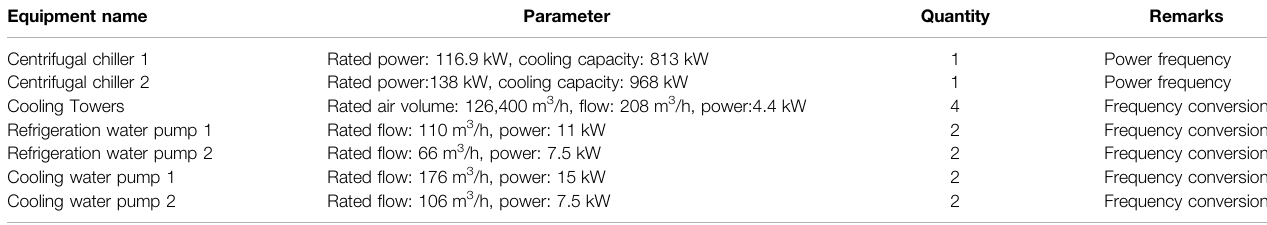
TABLE 1 | Central air conditioning system components.